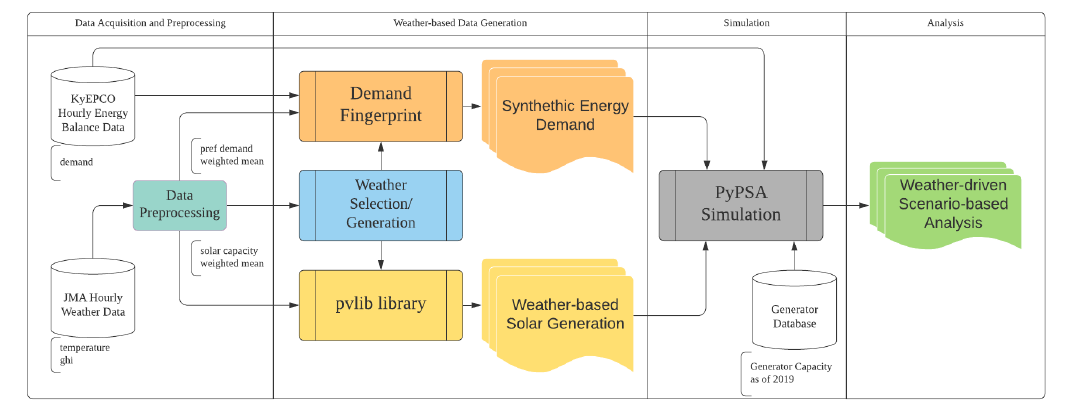
Figure 1. The proposed weather-driven scenario-based analysis approach capable of handling weather-related variations in electricity demand and solar energy